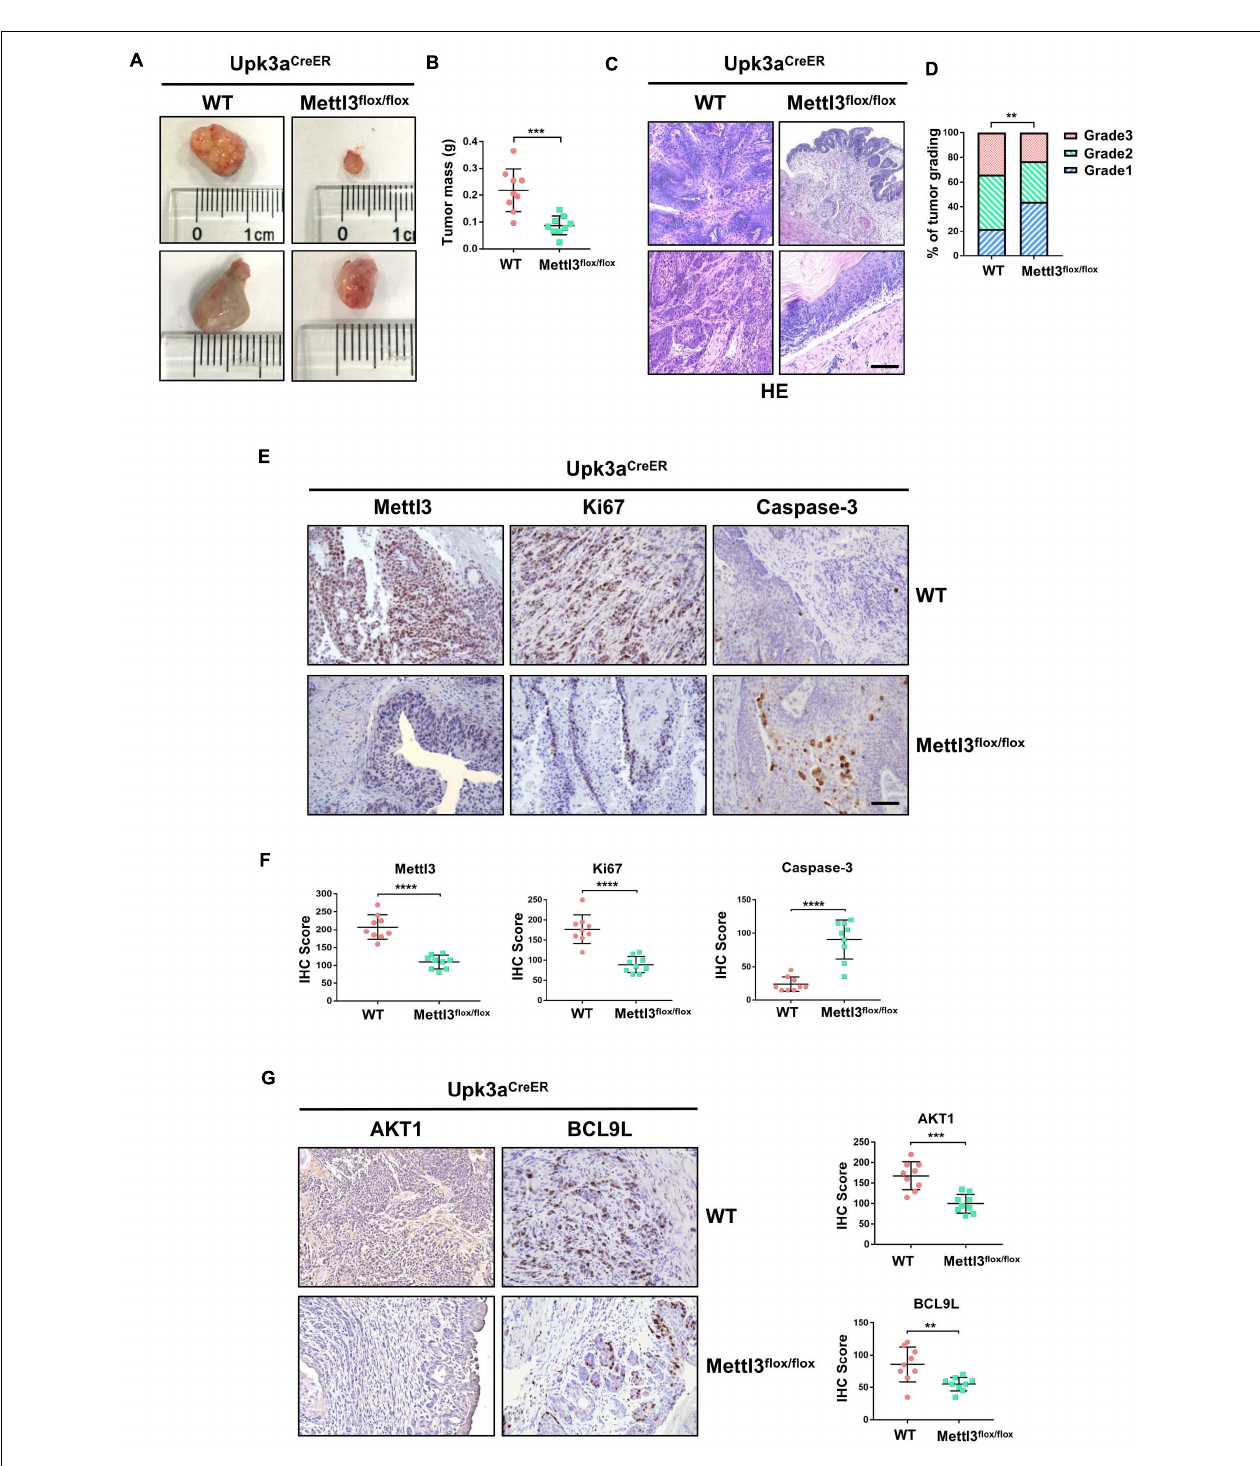
FIGURE 1 | Knockout of Mettl3 in urothelium inhibits the development of bladder cancer (BCa). (A) Representative images of BCa lesions from Upk3a CreER , Mettl3 wt / wt or Upk3a CreER , Mettl3 flox / flox mice 26 weeks after BBN treatment of at least three independent groups. (B) Statistics of bladder weight of mice in two groups. (C) Representative image of H&E staining of BCa section in wild-type and Mettl3 flox / flox mice. Tamoxifen was intraperitoneal injected into N-butyl-N-(4-hydroxybutyl) nitrosamine (BBN)-induced Upk3a CreER wild-type and Mettl3 flox / flox mice. Bladders were harvested after 24 h tamoxifen treatment. Scale bar, 100 µ m. (D) Statistics of tumor grading result was based on the H&E staining experiment. (E) Immumohistochemical staining for the expression pattern of Upk3a, Mettl3, Ki67, and Caspase-3 in both wild-type and Mettl3 flox / flox mice. Scale bar, 100 µ m. (F) Immunohistochemical staining scores of Mettl3, Ki67, and Caspase-3 were counted, respectively. (G) Immunostaining and IHC score of AKT1 and BCL9L in Upk3aCreER wild type and Upk3aCreER KO mice respectively.